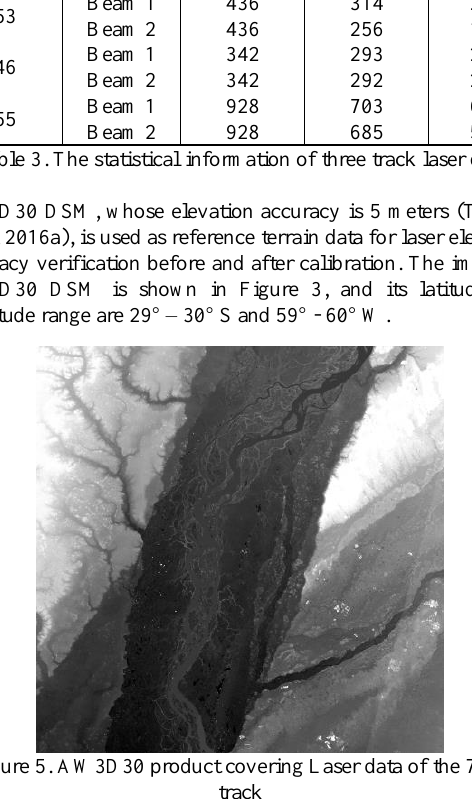
Figure 7. Elevation difference of the 153 th track laser data